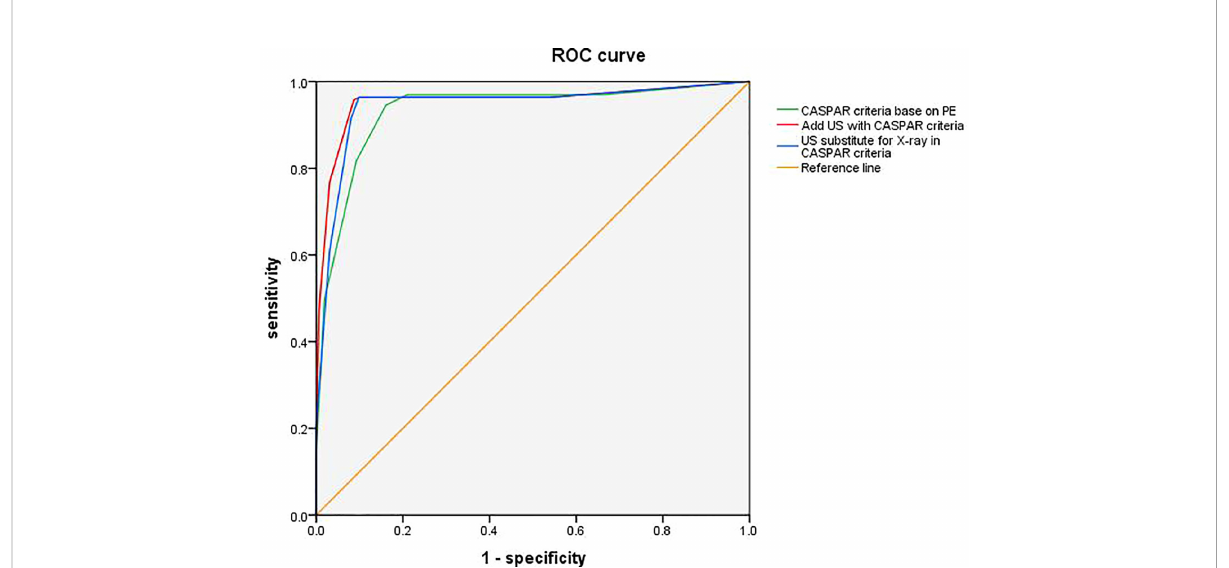
FIGURE 2 Receiver operating characteristic (ROC) curves for adding US or substituting X-ray by US in CASPAR. ROC curve illustrates the diagnosis performance of CASPAR with US added, CASPAR with replacing X-ray by US, and CASPAR based on physical examination only. The corresponding areas under the ROC curves (AUC) were 0.954 (95% CI 0.928, 0.979; p <0.01), 0.944 (95% CI 0.916, 0.972; p <0.01), and 0.933 (95% CI 0.903, 0.962; p <0.01). CASPAR, ClASsi fi cation criteria for Psoriatic Arthritis; US,